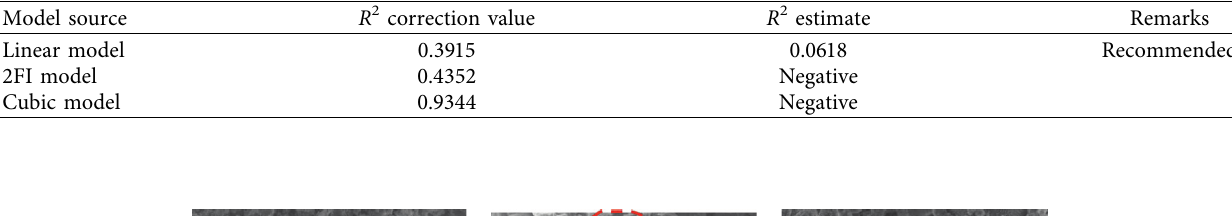
Table 5: Analysis of the fitting degree of each model by the response surface method.